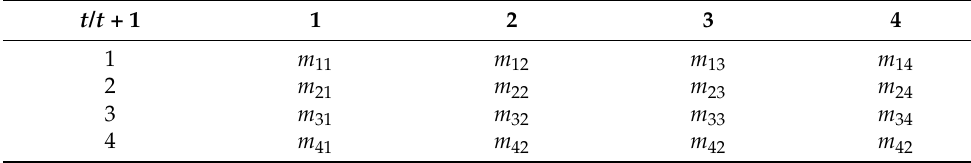
Table 3. Markov transition probability matrix n ( k =